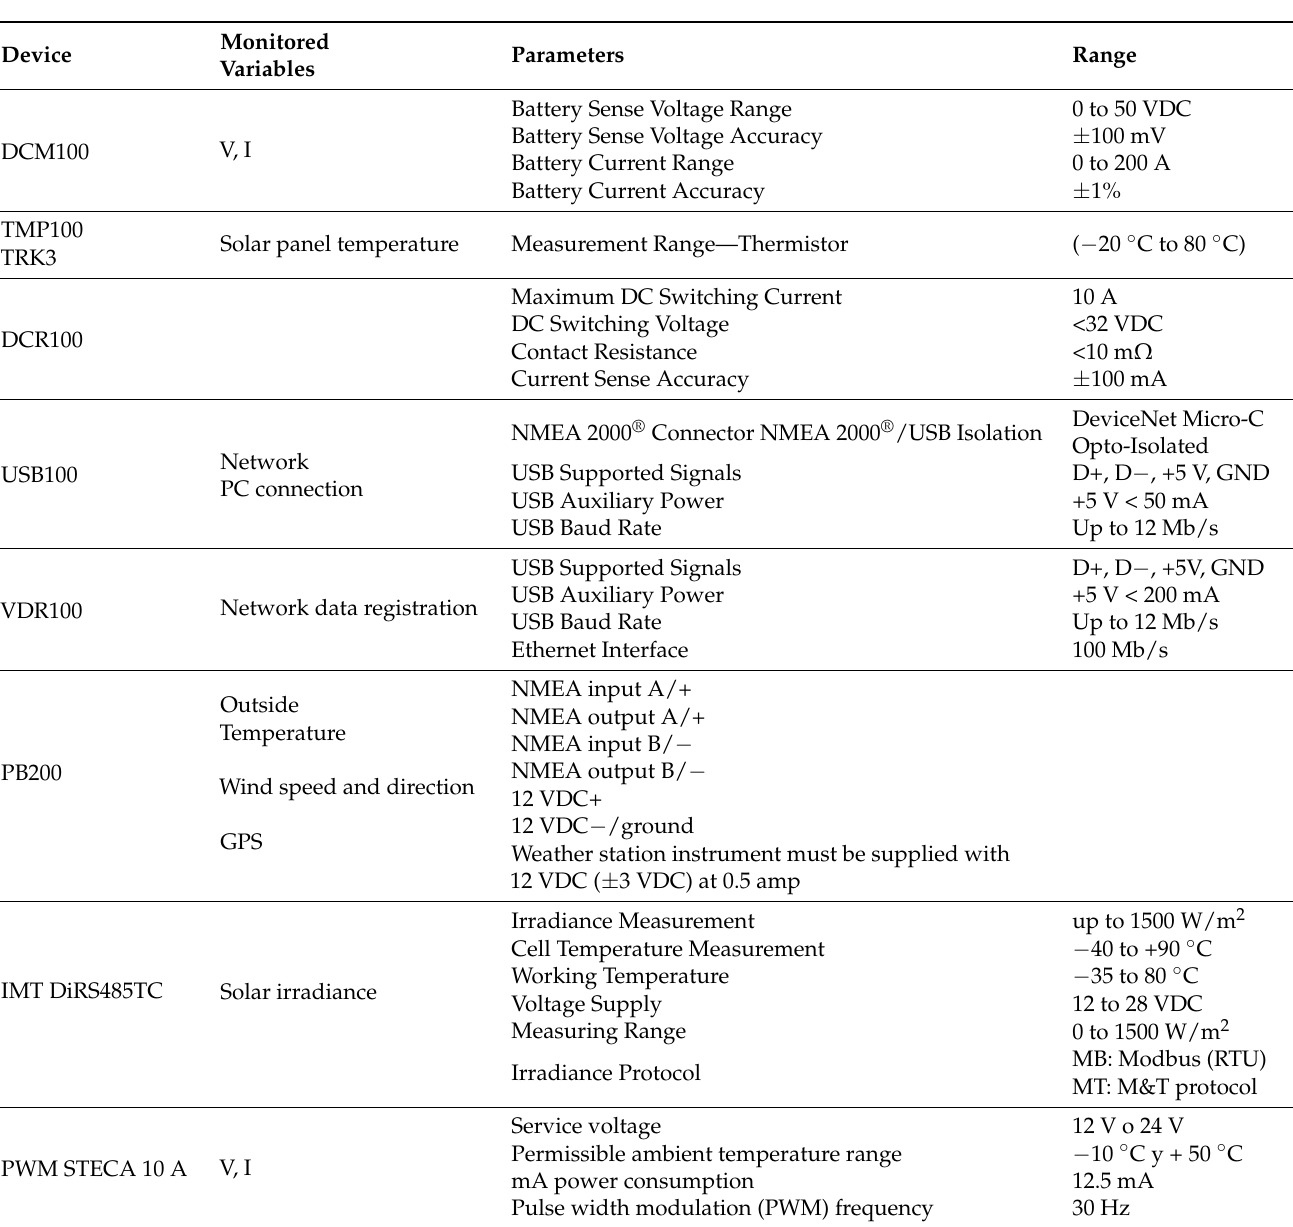
Table 1. PVI sensors and